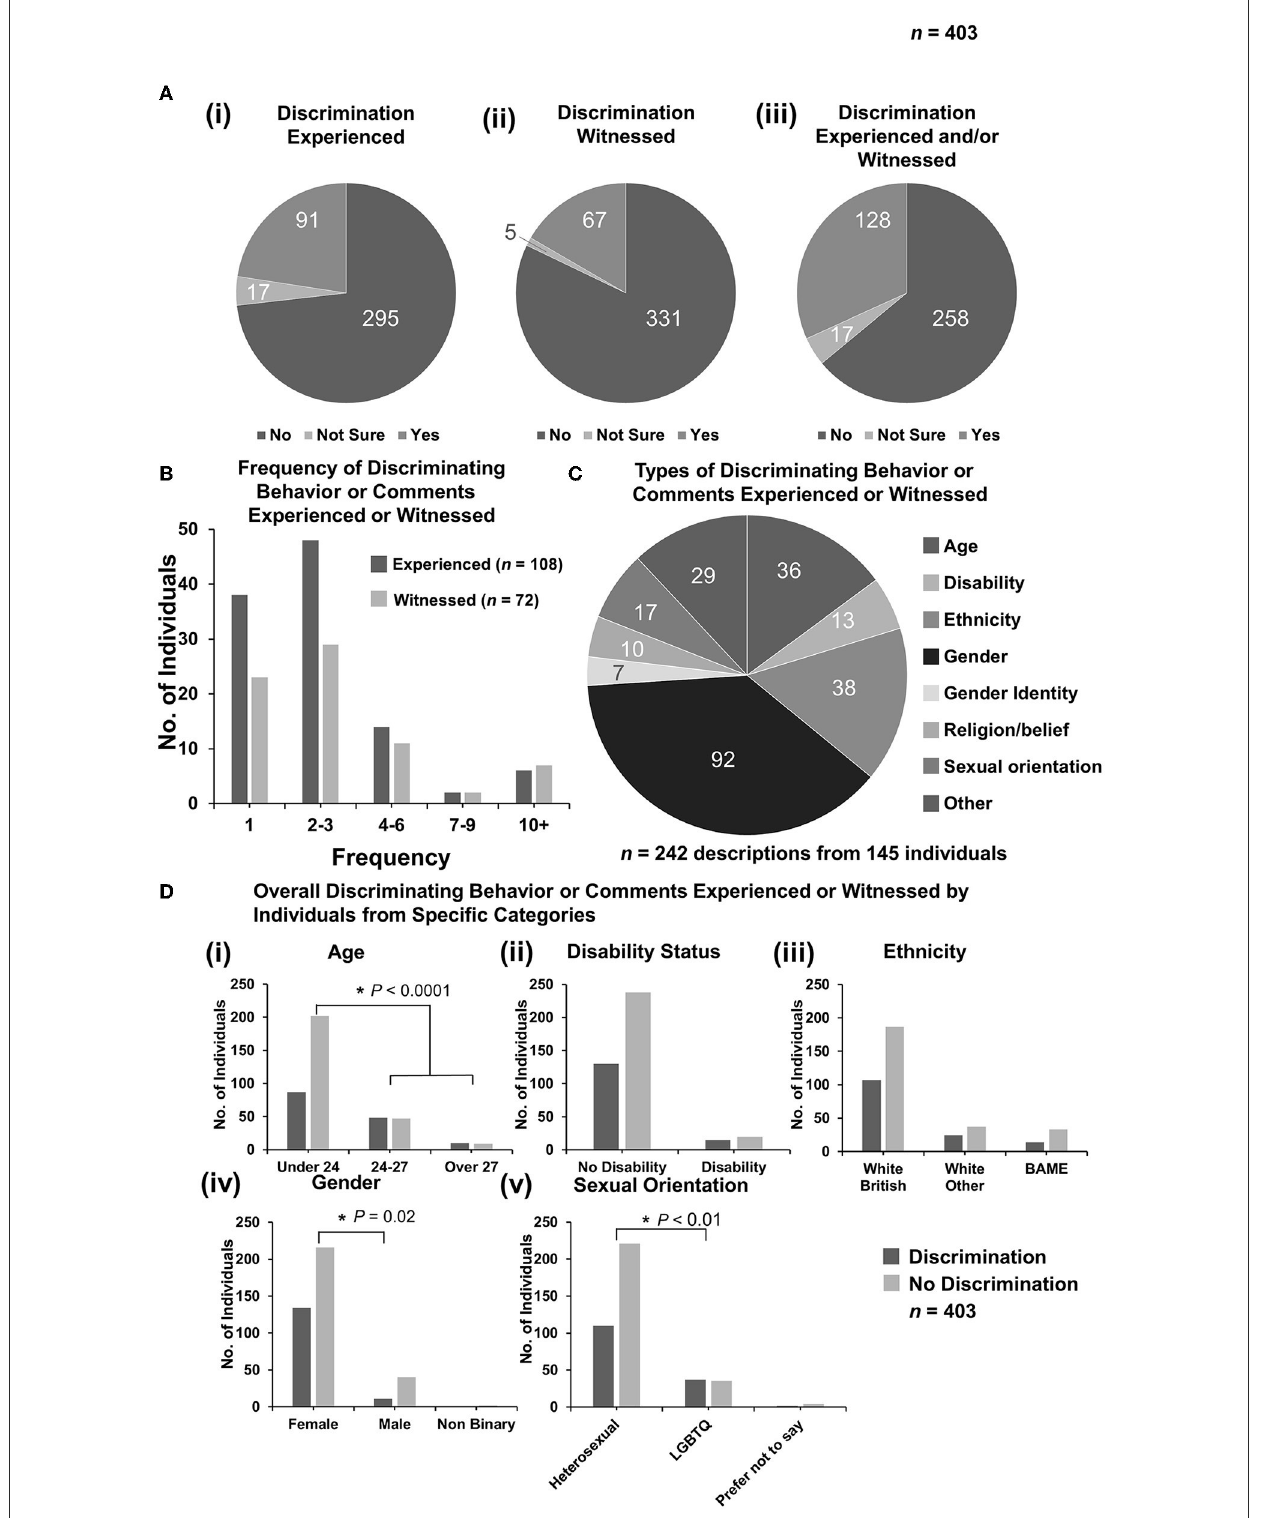
FIGURE1 Discriminating behavior or comments experienced or witnessed by respondents. (A) Pie charts to demonstrate the numbers of responses for categories of “yes”, “not sure”, and “no” for (i) experienced, (ii) witnessed, or (iii) either experienced or witnessed ( n = 403). Respondents who both experienced and witnessed discrimination were only counted once. Analysis of free-text descriptions of incidents experienced or witnessed enabled the inclusion of responses of “not sure” to be included as “yes” for further figure parts. (B) Column graph to demonstrate the frequency of discriminatory behavior or comments experienced ( n = 108) or witnessed ( n = 72) by the number of respondents selecting a frequency category. (C) Pie chart demonstrating breakdown of experienced or witnessed discrimination [from (A) iii] by category. Some incidents described by respondents could be categorized under more than one category, for example, age and gender ( n = 242 descriptions from 145 responses). [ (D) i–v] Bar graphs demonstrating total overall discrimination experienced or witnessed vs. no discrimination broken down by demographic categories. Statistical significance was determined by Pearson’s chi-squared test. * P <